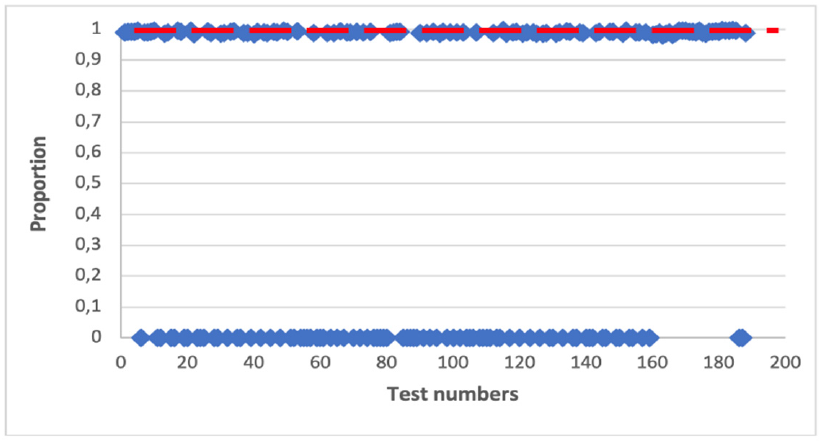
Figure 7. Statistical portrait of the MAFG output sequence at р = 137, X (0) = 1, a = b 0 ⊕ b 1 … ⊕ b 7 .